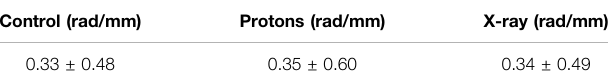
TABLE 2 | Pixelwise curvature mean and standard deviation (SD) of each